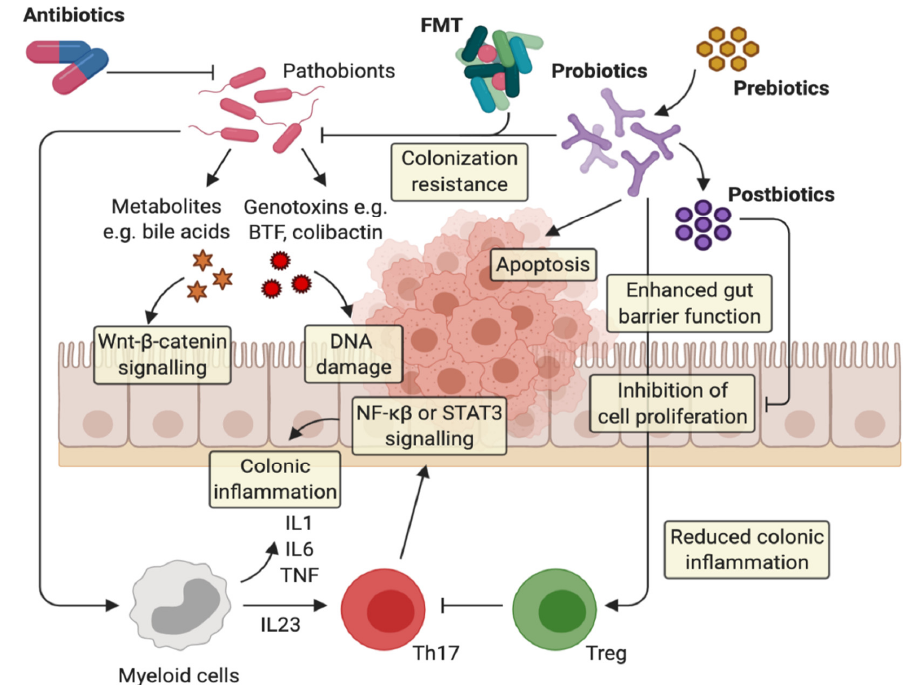
Figure 1. The gut microbiota can influence colorectal carcinogenesis via a variety of mechanisms, including microbial-derived factors such as metabolites or genotoxins. Skewed host–microbe to the progression of CRC. Antibiotics usage is e ff ective in eradicating pathobionts, but its